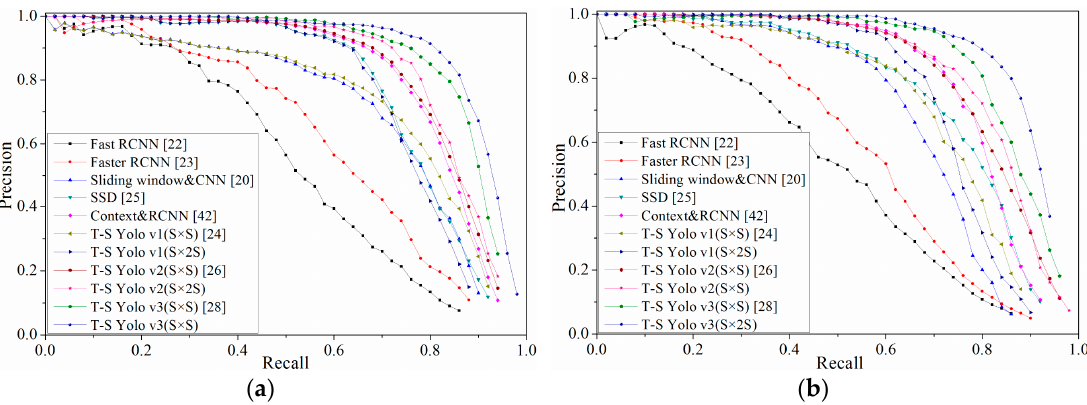
Figure 8. PR curves of all algorithms on the two datasets. ( a , b ) are the PR curves on the KITTI and Caltech dataset, respectively.